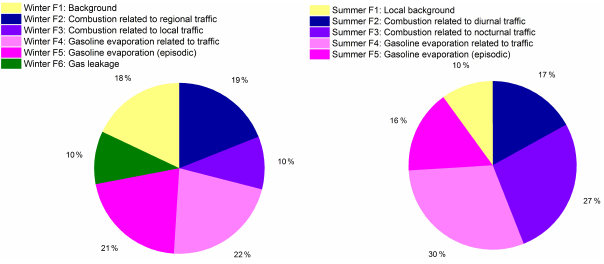
Figure 11. Sources contribution (wt%) in winter and in